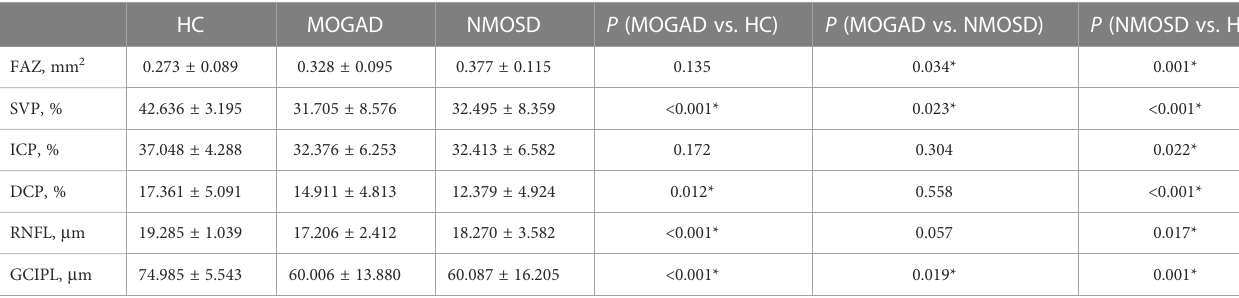
TABLE 2 Comparison of OCT/OCTA parameters.